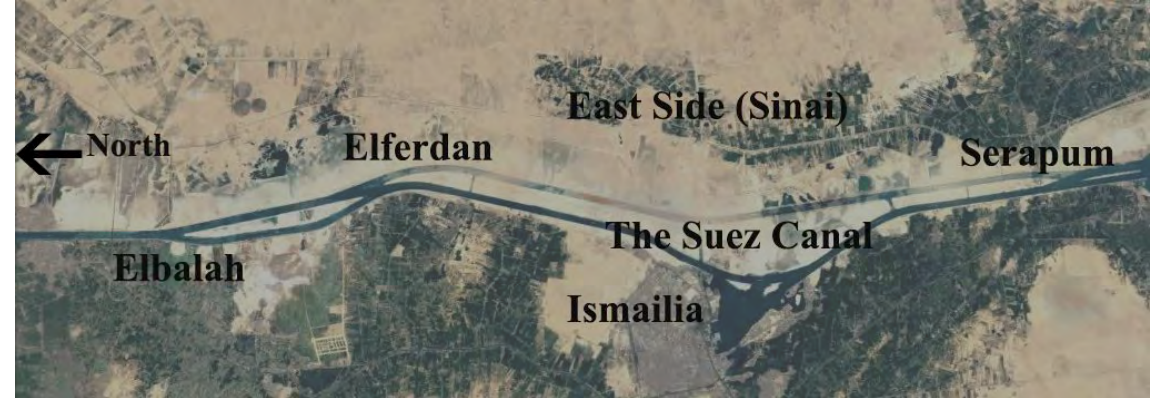
Figure 6. The second zone covers the area from Elferdan running south to